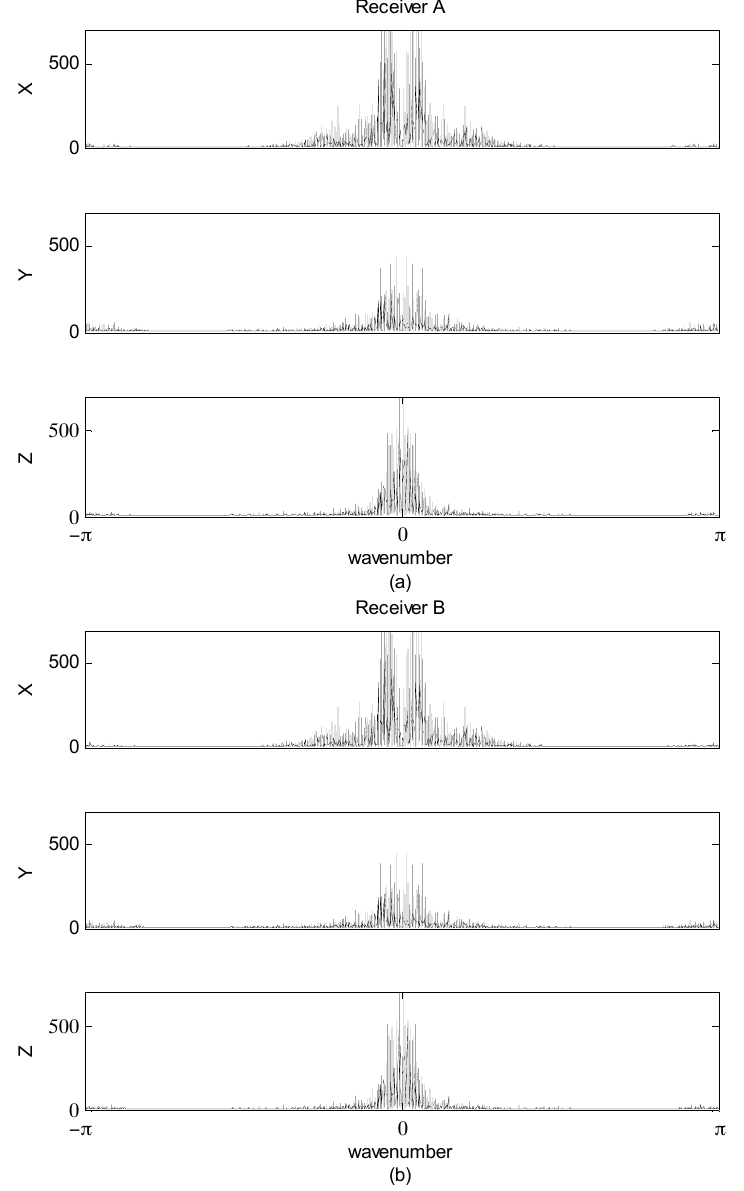
Figure 4. Kinematic acceleration power spectra in m 2 /s 4 : ( a ) Receiver A; ( b ) Receiver B.